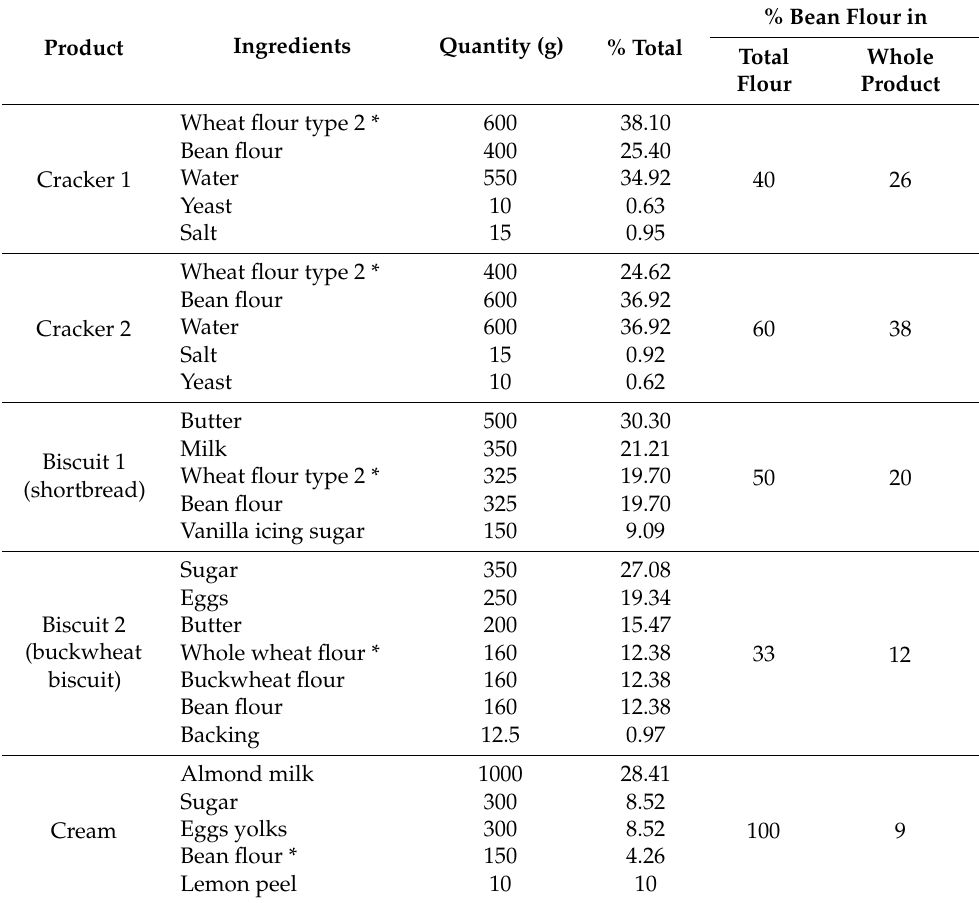
Table 1. Formulations of bean-based food